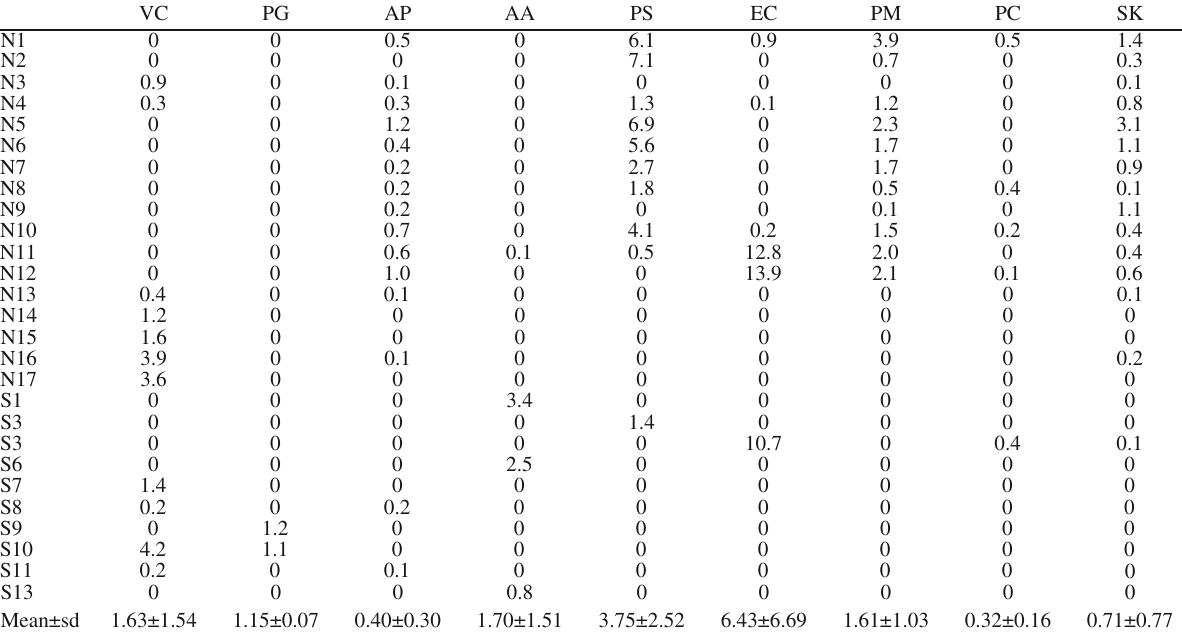
Table 3. – Results of the PERMANOVA testing for the effects of the zone (north [N] and south [S]) and substrates (hard [H]; mixed [M]; soft [S]) on the composition and abundances of Marmara soft coral assemblages. PERMANOVA (Species Composition)